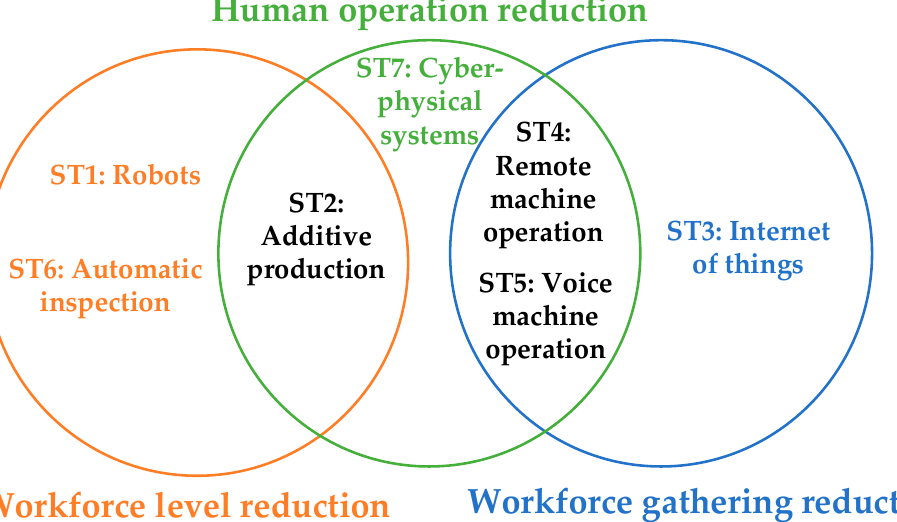
Figure 2. Smart technologies and objectives in sustainable manufacturing.